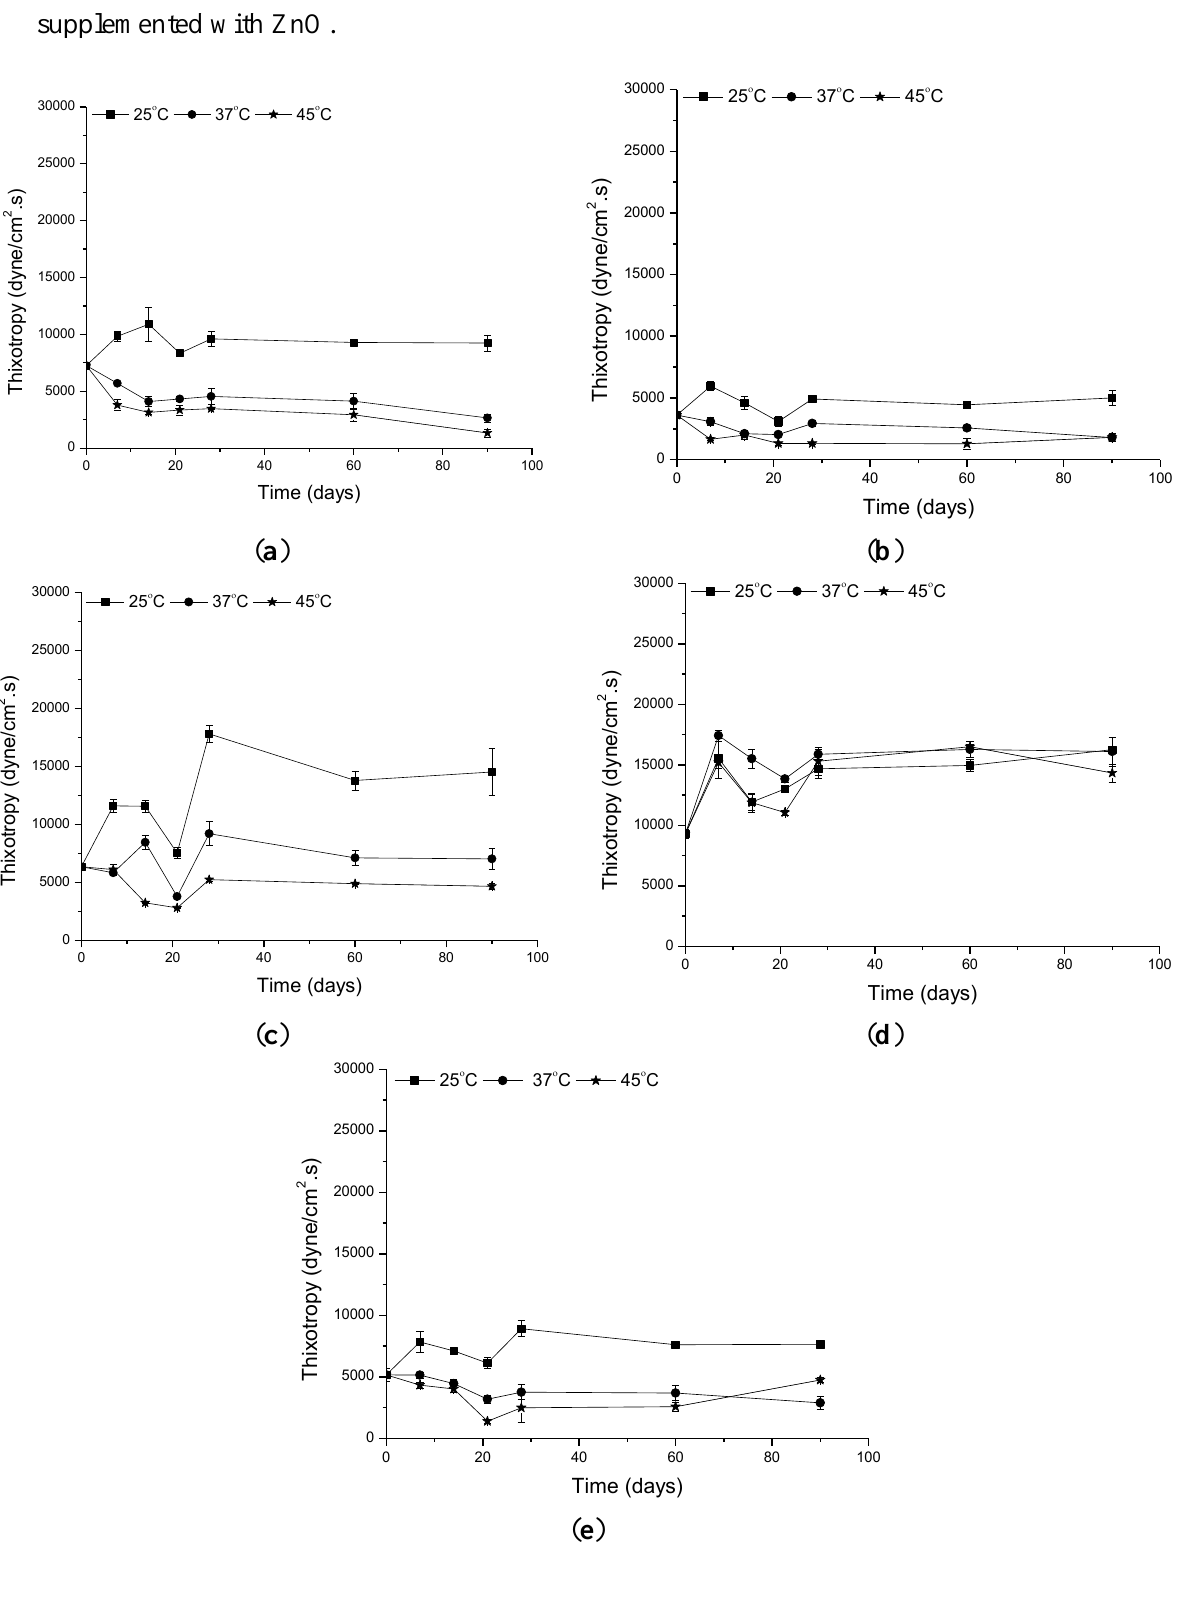
; and ( e ) formulation 2